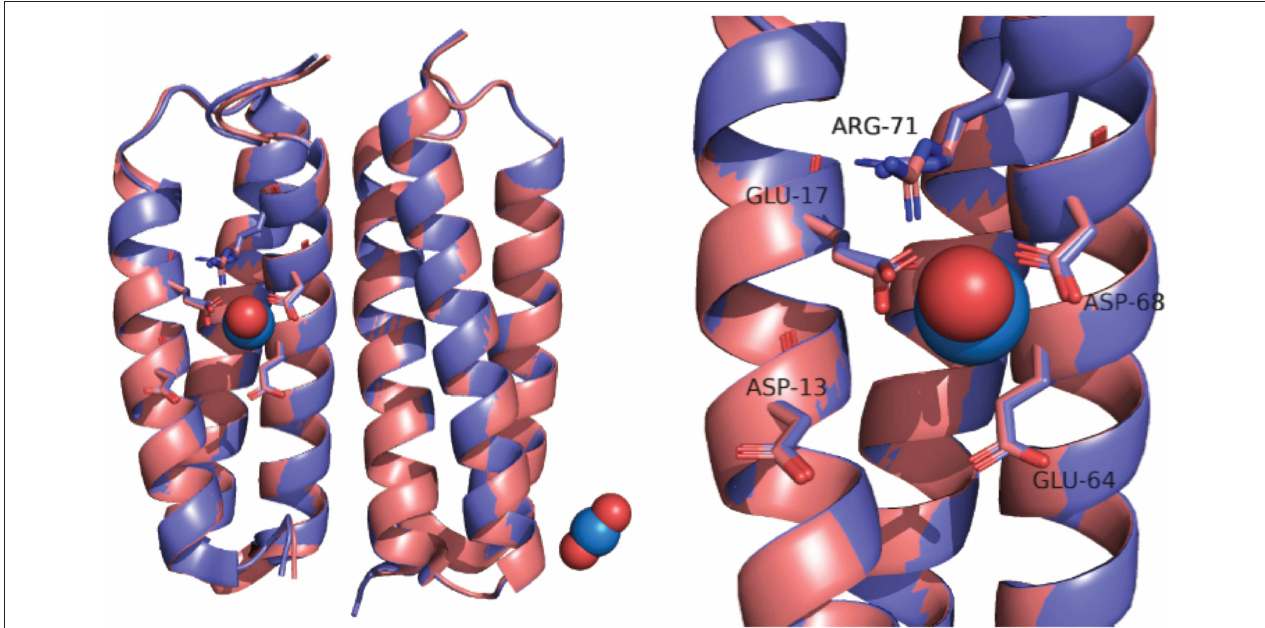
FIGURE 1 | Overlay of SUP crystal structures obtained with (pink) and without UO 2 + 2 bound